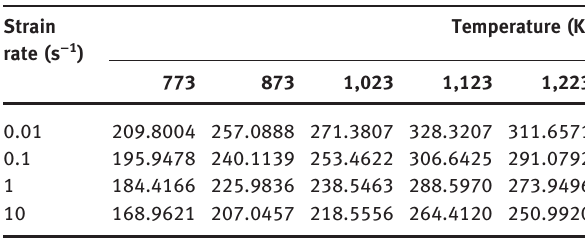
Table 2: The apparent activation energy at different deformation temperatures and strain rates